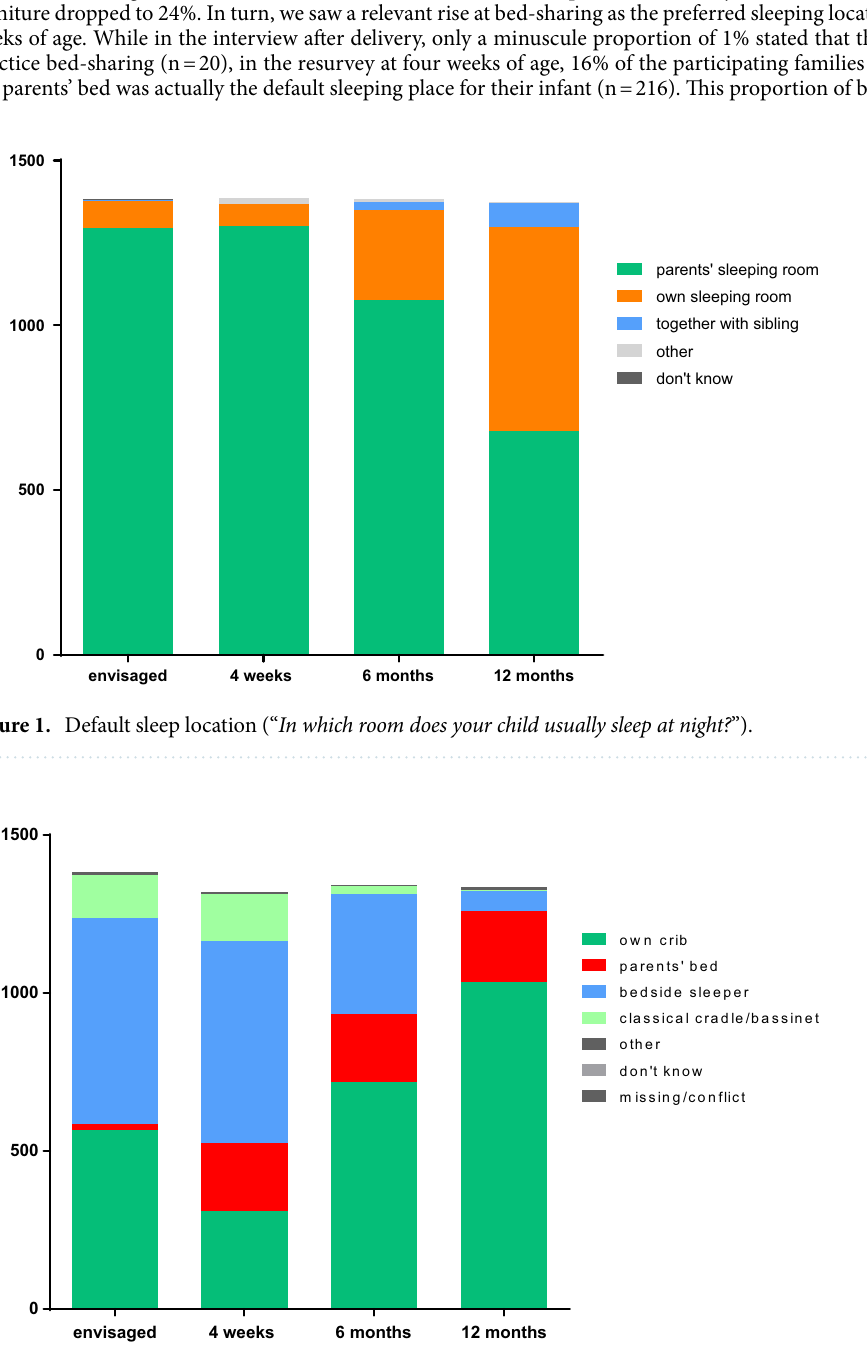
Figure 2. Standard sleeping furniture (“ What does your child usually sleep in at night?